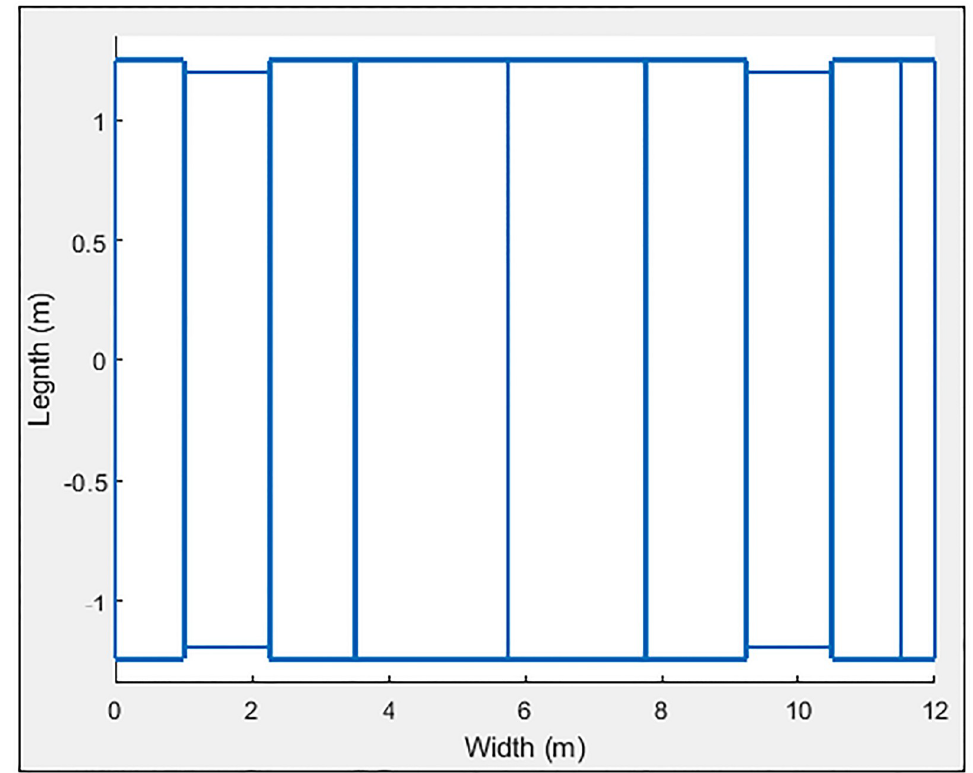
Fig 18. Bus characterized in 9